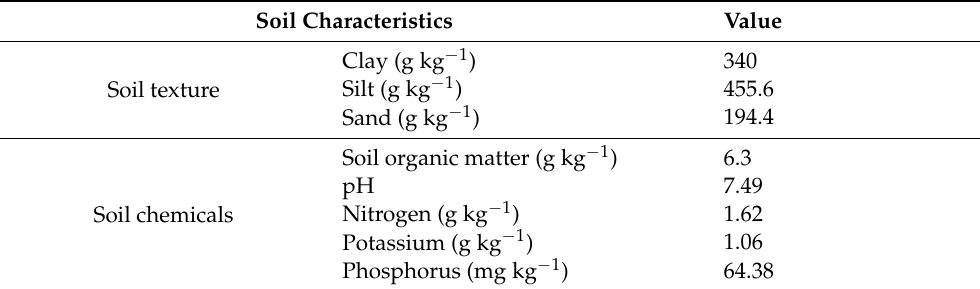
Table 1. Soil characteristics of the top layer before implementing the long-term field experiments. Soil Characteristics Value Soil